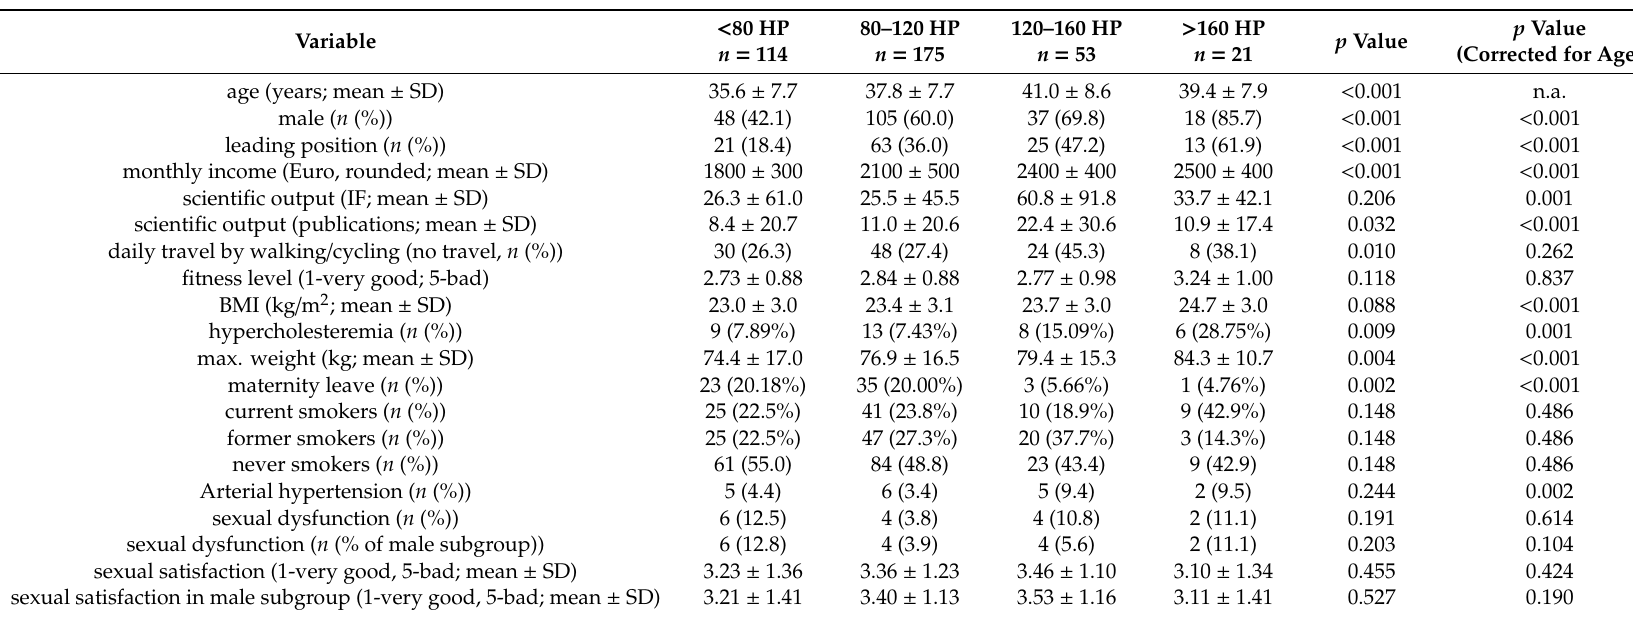
Table 1. Associations of horsepower (HP) of Austrian physicians’ cars with health determinants ( n : number; SD: standard deviation; kg: kilogram; m: meter).